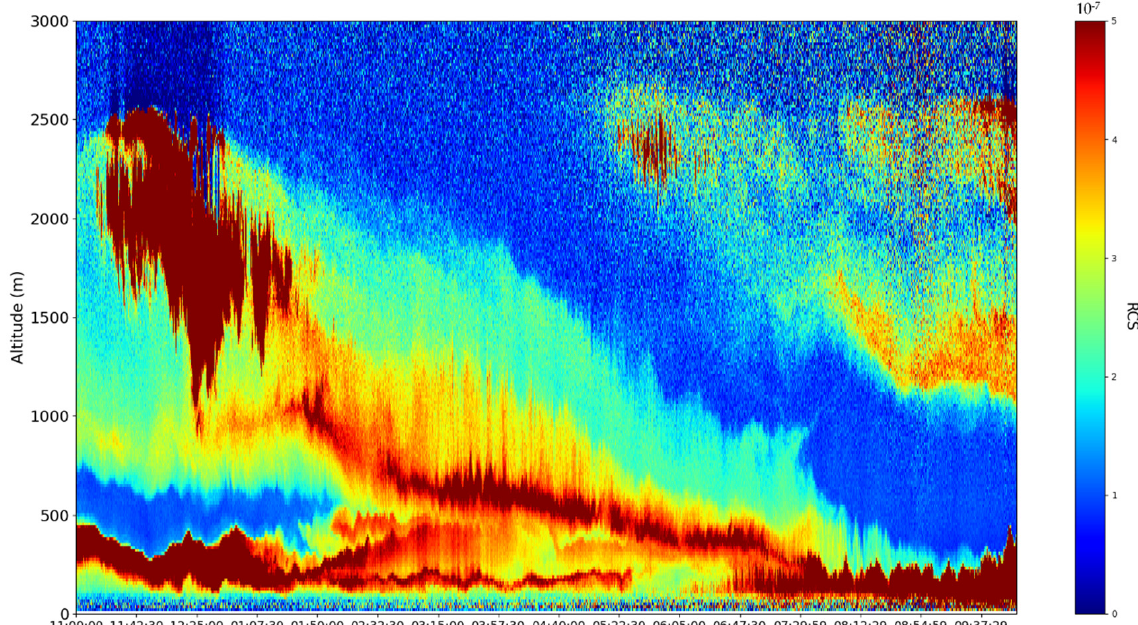
Figure 8. Zoomed-in RCS timeseries, λ = 1064 nm , Gala ț i, Romania, 22 December 2021.